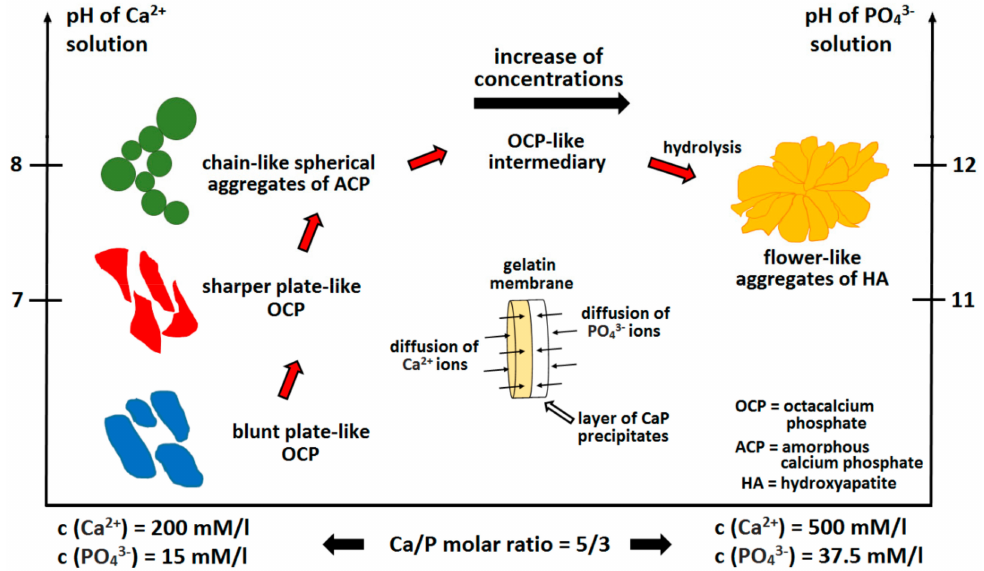
Figure 4. The formation of various CaP aggregates in GEL as a template by means of varying pH values and the concentrations of source ions, according to Teng et al.